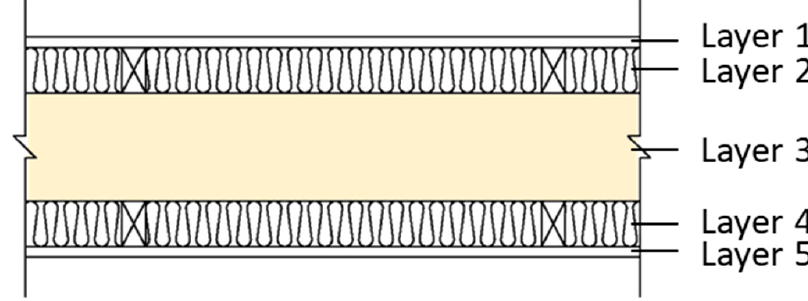
Figure 3. The diagram of CLT + GB (C1–C4).